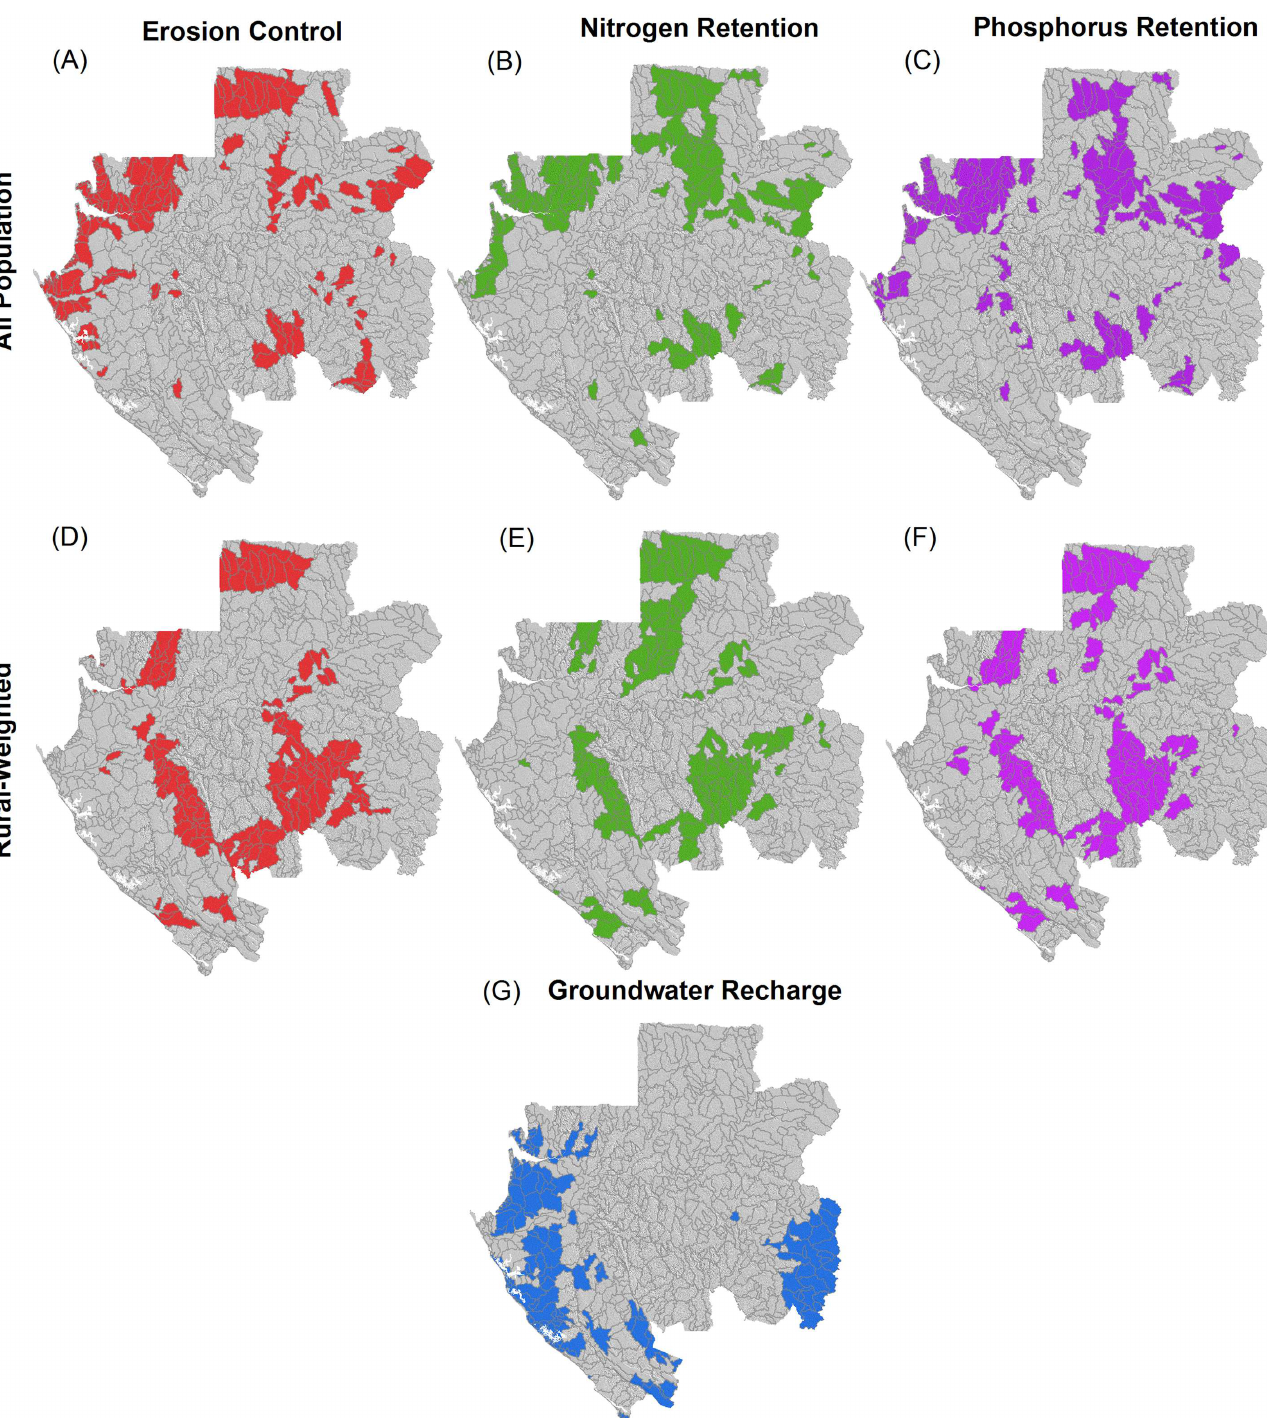
PLOS ONE | https://doi.org/10.1371/journal.pone.0179008 June 8, 2017 12 /